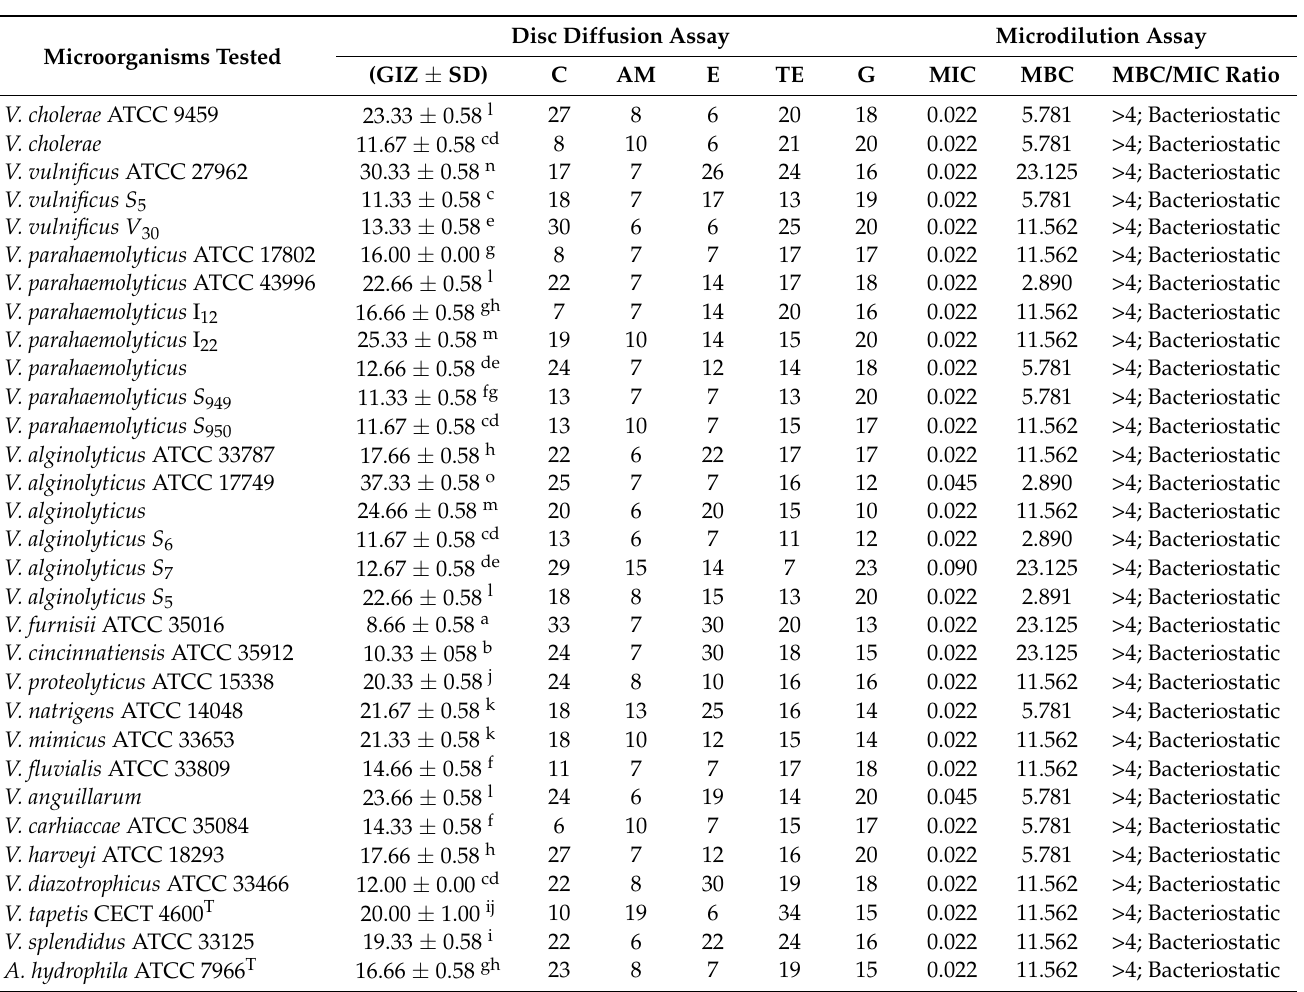
Table 3. Antimicrobial activity of the tested Carum essential oil evaluated by disc diffusion and microdilution assays as compared to five antibiotics. GIZ: Mean of Growth Inhibition Zone. The letters (a–o) indicate a significant difference between the different means of GIZ according to